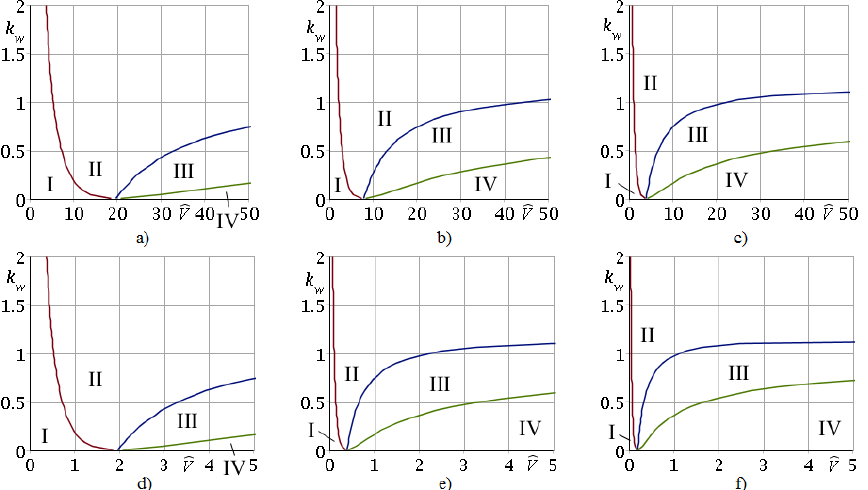
Figure 3. Domains of stability (I, II) and instability (III, IV) of the problem solution at Bi = 100 for different values of η : ( a ) 0.1, ( b ) 0.25, ( c ) 0.5, ( d ) 1.0, ( e ) 5.0, ( f ) 10.0. Note that the dimensionless parameter η , which characterizes inhomogeneity of the FGM of the coating, significantly affects the boundary between domains of stable (II) and unstable (III) solutions for any k w . These boundaries are presented in Figure 4 in detail. One can observe that with decrease in η , the stable solution region increases.